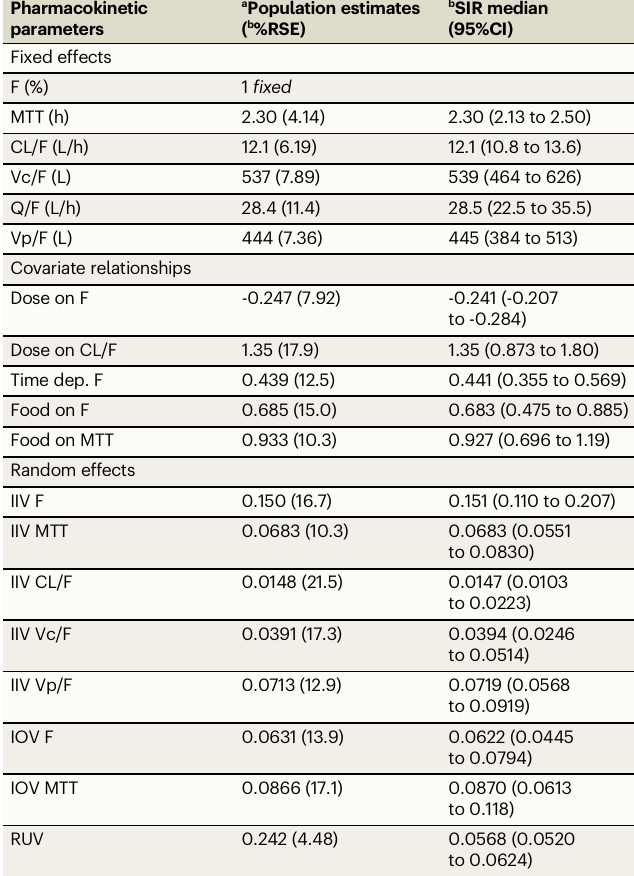
Table 3 | Final pharmacokinetic parameter estimates of TD-6450 Pharmacokinetic